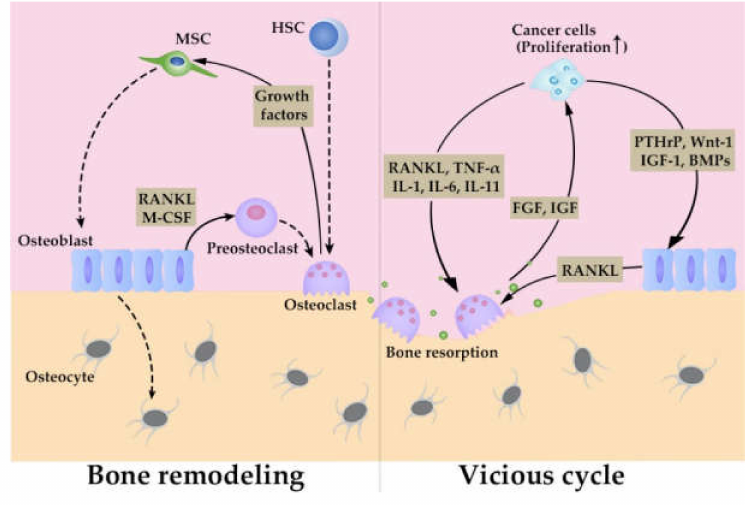
Figure 2. Bone remodeling and vicious cycle in bone